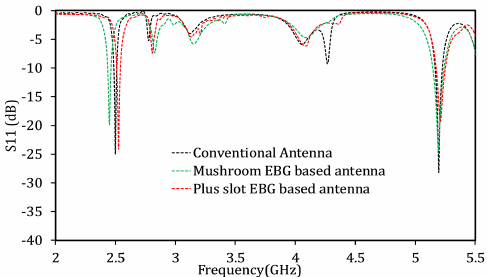
Figure 14. Return loss without EBG and with EBG ground